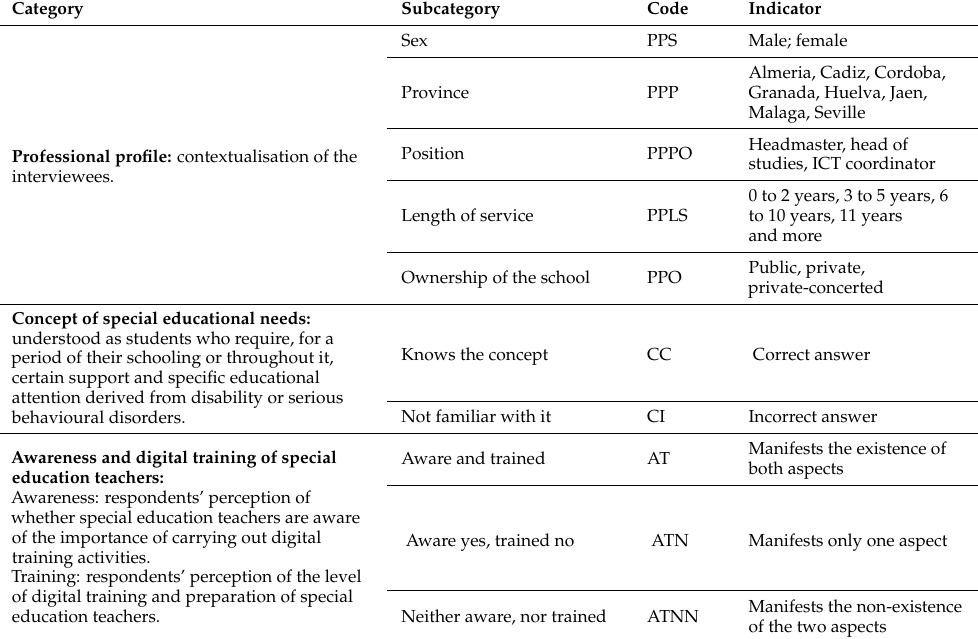
Table 3. Categories, subcategories, codes, and indicators resulting from the interpretative analysis of the